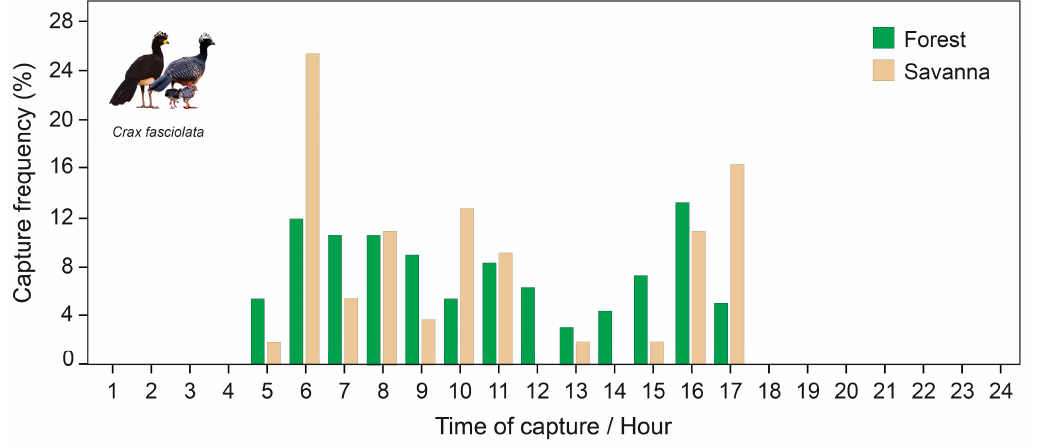
Figure 6. Frequency (%) of independent captures of Bare-faced Curassow ( Crax fasciolata ) (based on a 30 min independence interval) in forest and savanna-dominated habitats obtained in the Northern Pantanal (Mato Grosso, Brazil) from July 2015 to December 2017, grouped into 1 h periods.